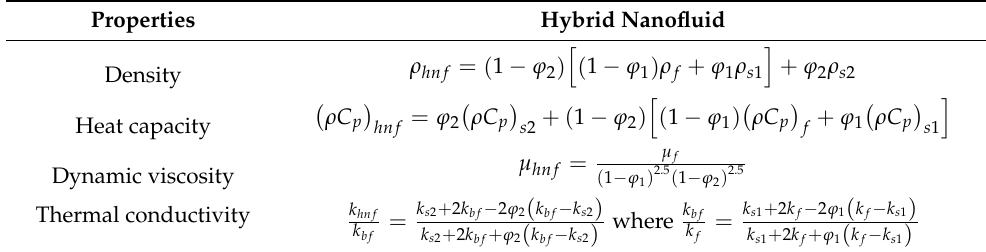
Table 1. Physical traits of hybrid nanofluids (Devi and Devi [38]).